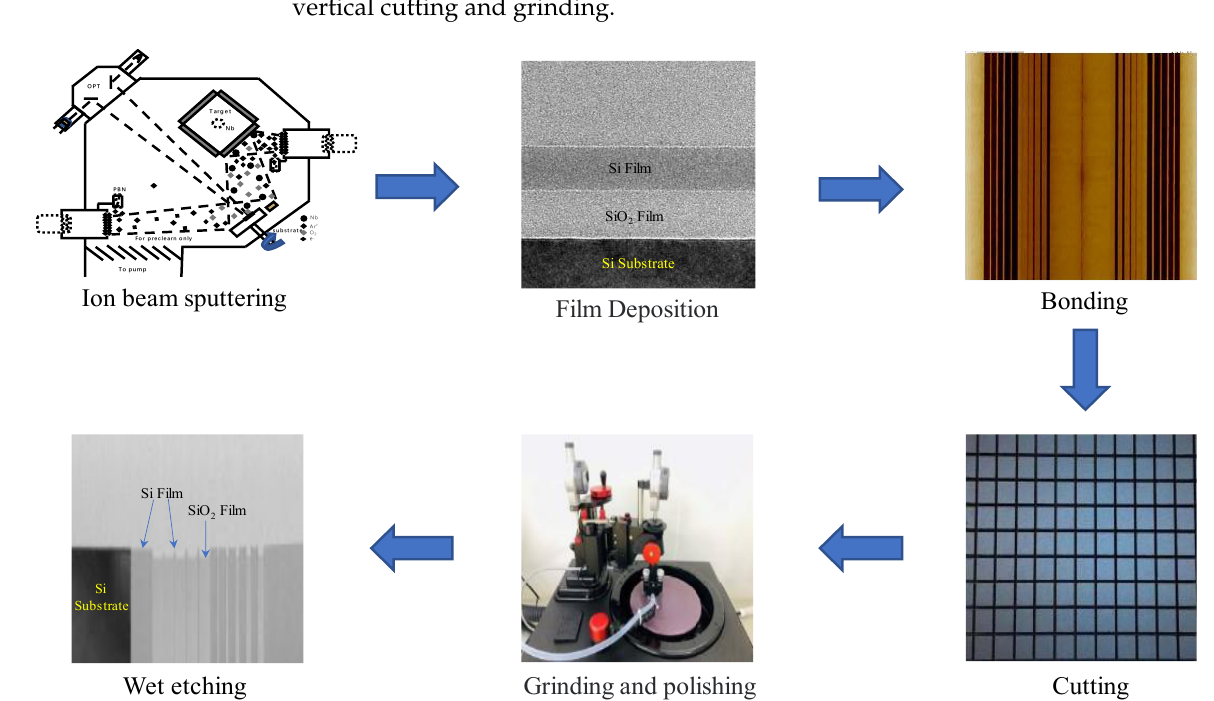
Figure 1. Fabrication process of tip characterizer based on multilayer deposition technique.